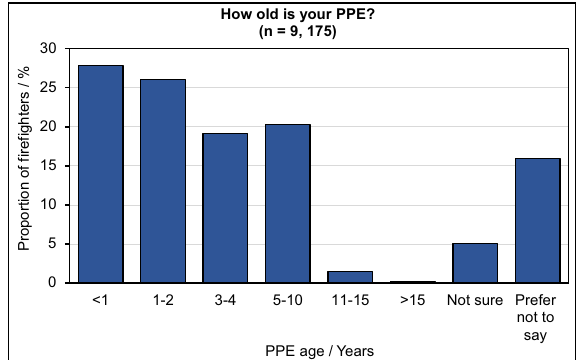
Figure 1. Age of UK Firefighters’ PPE. Proportion of firefighters with individually issued PPE indicating the age of their